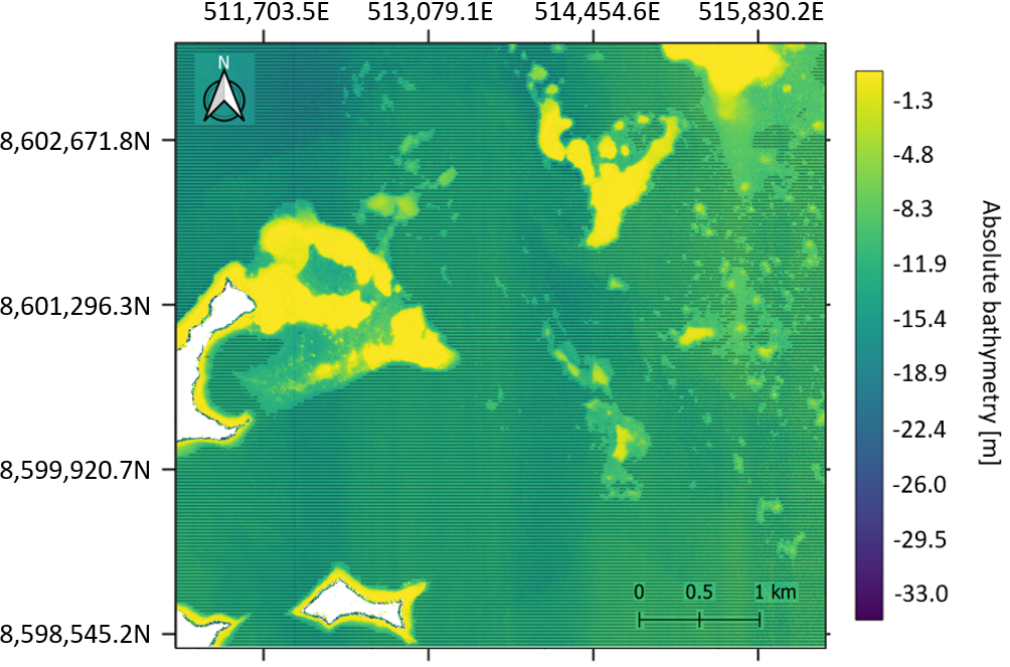
Figure 8. ( a ) Relative DDM with superposition of ICESat-2 bathymetric points; ( b ) 2nd degree polynomial regression. Figure 9 shows the final DDM obtained using ENVI through the application of the model to the relative DDM. The hatched areas correspond to depths greater than the max- imum calibration depth.